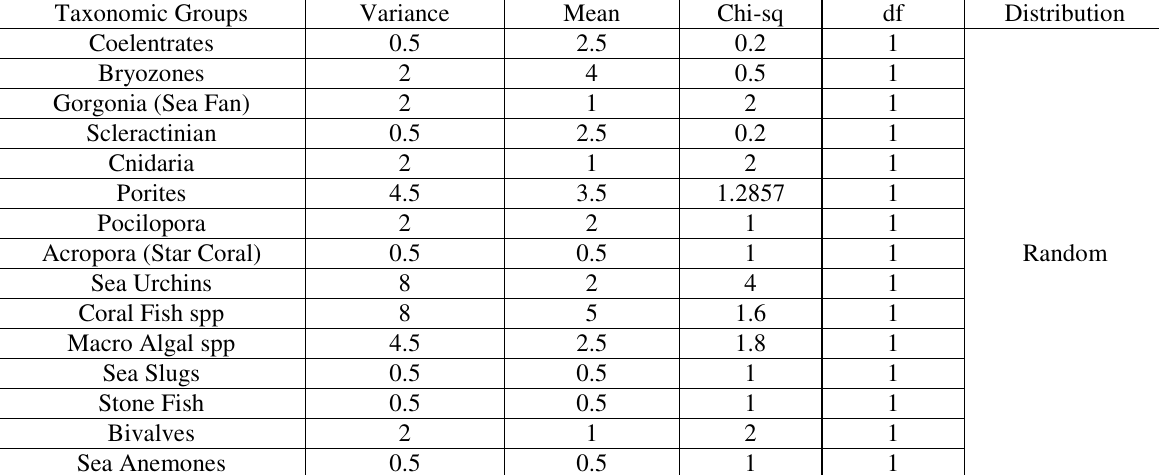
TABLE 4. CORAL COMMUNITIES OBSERVED AT CHURNA ISLAND LOCATION SHOWED RANDOM DISTRIBUTION